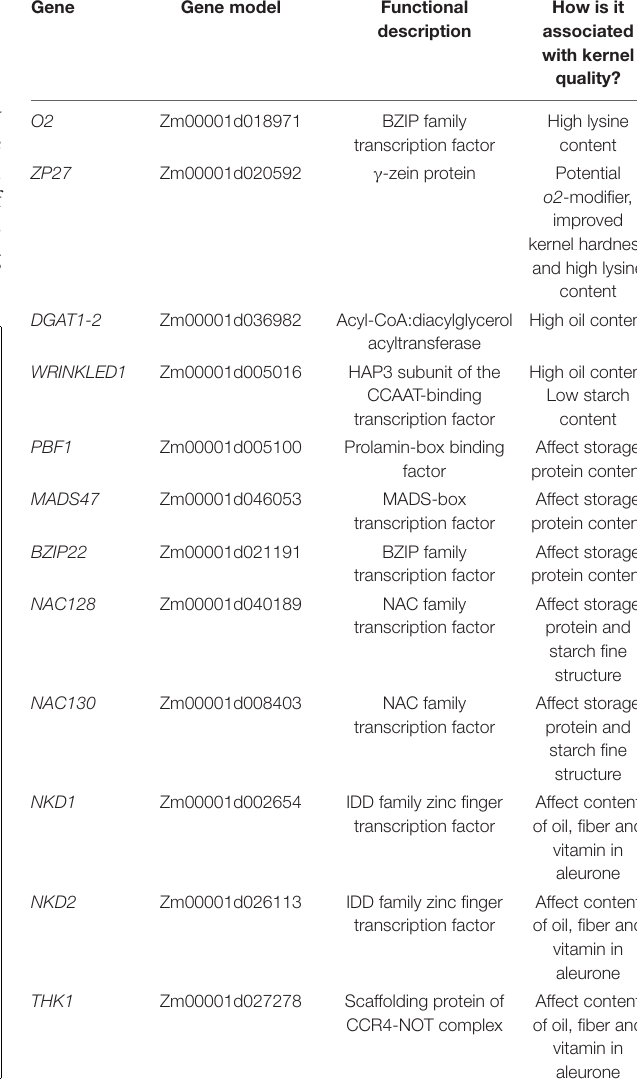
TABLE 2 | Examples of key genes associated with maize kernel